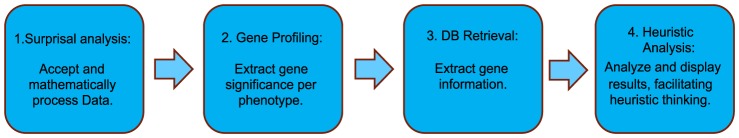

Computational Surprisal Analysis.Software Architecture of the integrated tool.